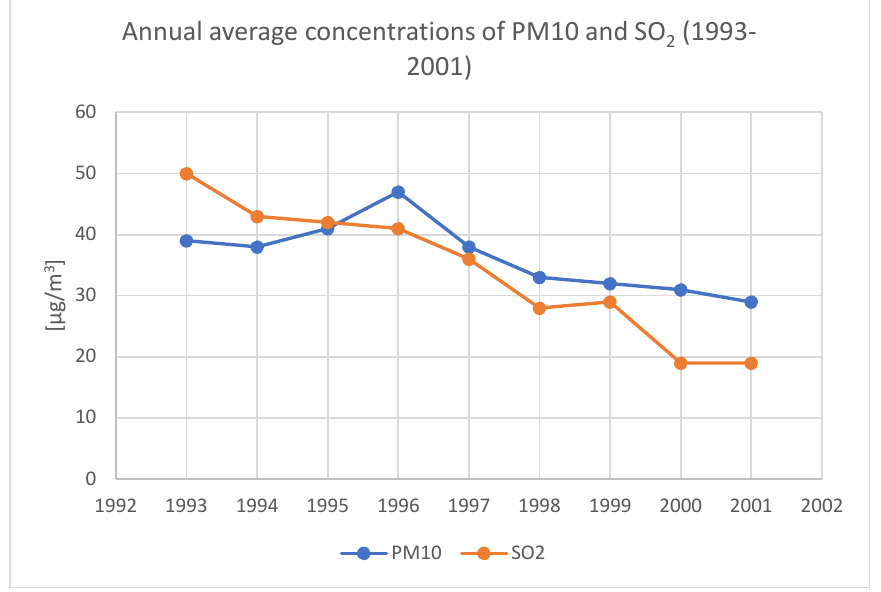
Figure 2. Annual average concentrations of PM10 and SO 2 in Krakow in 1993–2001 (based on the State of the City Reports 1993–2001 [48]).